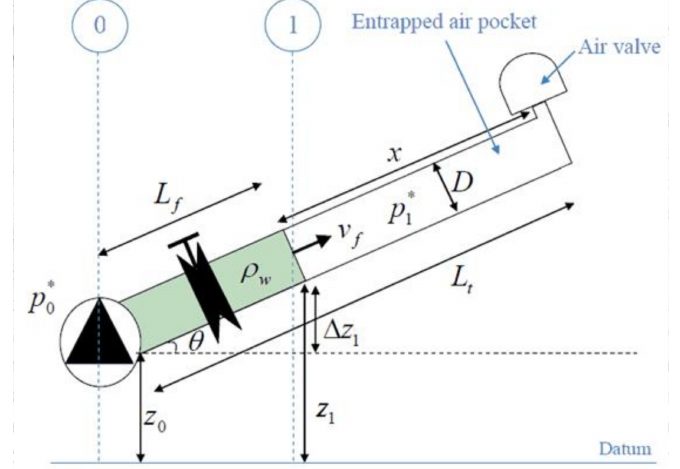
Figure 1. Scheme of a filling process in a single pipeline with an air